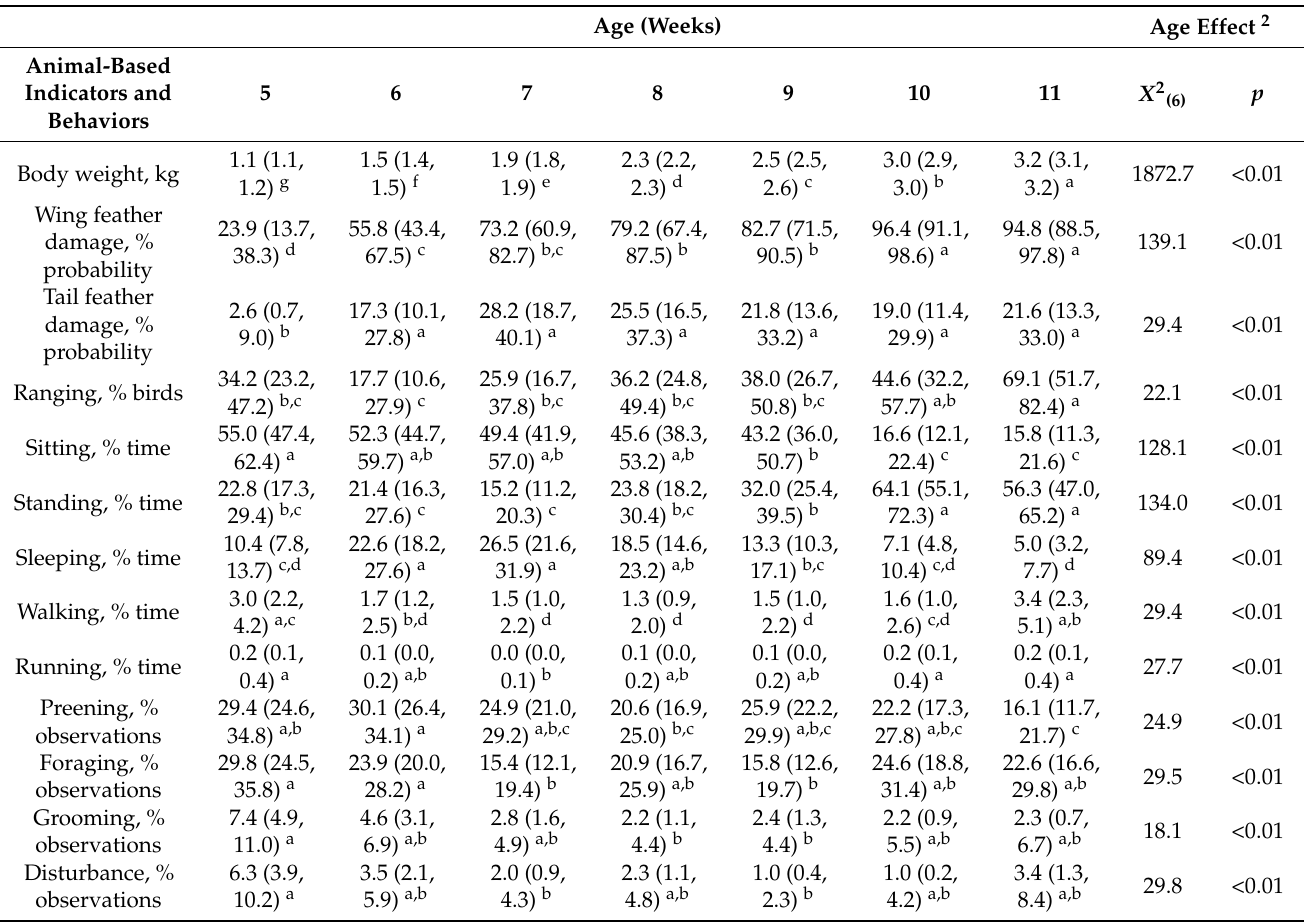
Table 2. Means ± 95% CI of animal-based indicators and behaviors affected by age for mixed-sex Freedom Ranger chickens raised in a free-range system from 5 to 11 weeks of age 1